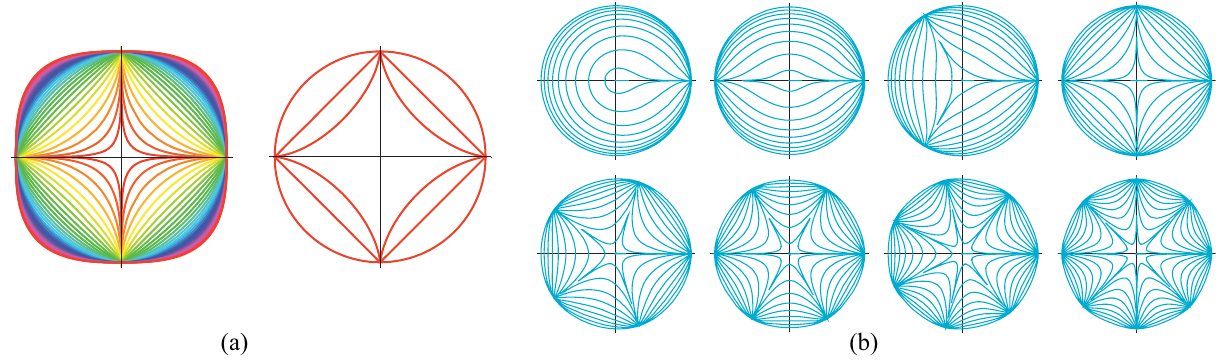
Figure 19. (a) Lamé curves for n = 2/3, 1 and 2. (b) Gielis curves for m = 1, 2, 5, 6. Each fi gure shows various curves for different exponents